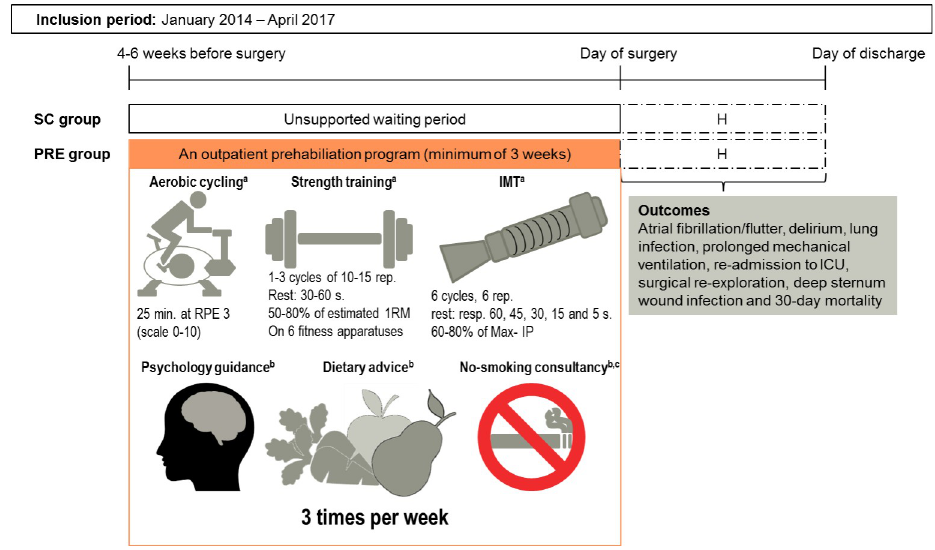
Fig 1. An overview of the prehabilitation (PRE) group and standard care (SC) group. The prehabilitation program was part of a pilot of the Heart-ROCQ program 28 , which continued with a clinical inpatient rehabilitation phase following discharge from the hospital. Including two group education sessions about basic training principles and forced expiration technique and huff and cough techniques and 30 minutes sessions of body awareness were given every 2 weeks. b Including intake, individual sessions on indication, and group education on cardiovascular risk factors; c Only for patients who smoke; H: Hospitalization; ICU: Intensive care unit; IMT: Inspiratory muscle training; Max-IP: Peak inspiratory pressure; PRE-group: patients who followed the prehabilitation program; RPE: rate perceived exertion; SC-group: Standard Care group, who did not have the option to follow prehabilitation; 1RM: One Repetition Maximum, estimated based on 6-10RM.